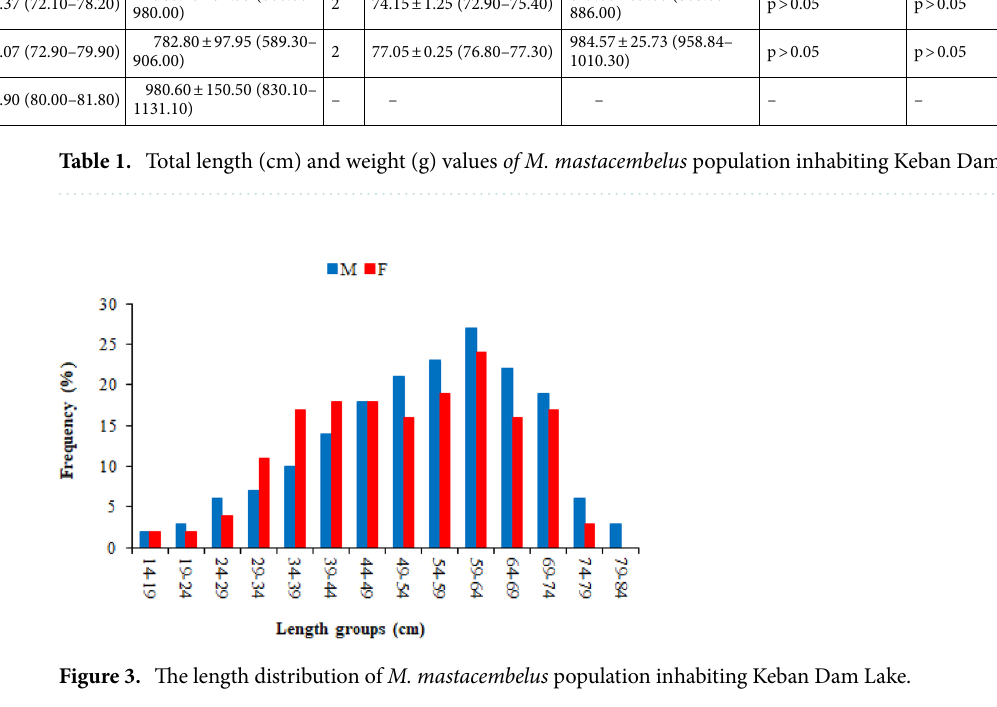
VII, VIII, XI and XIV age groups (p < 0.05).